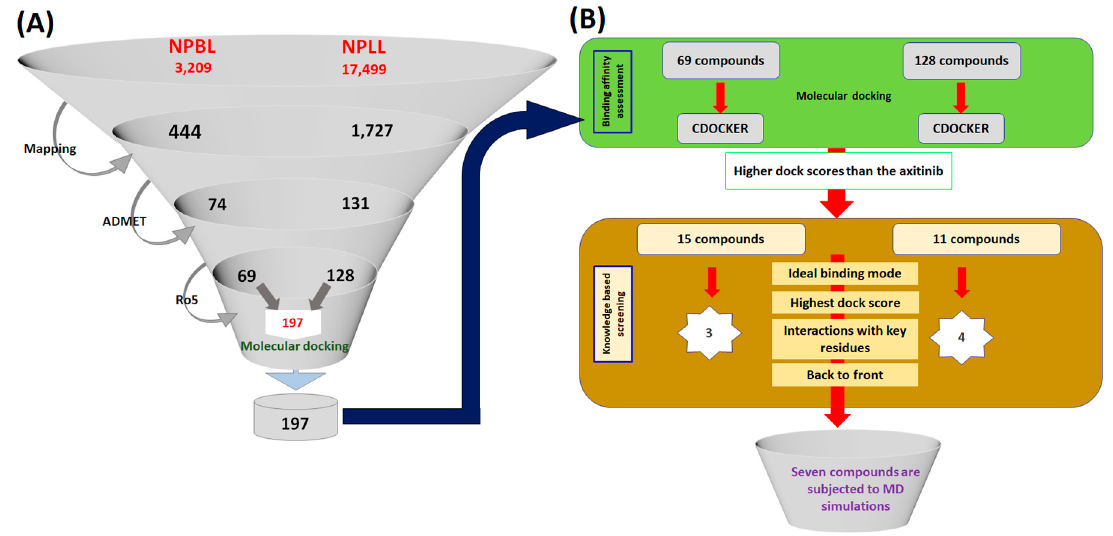
Figure 3. Pictorial depiction of the steps involved in the identification of the potential compounds. ( A ) Illustration of virtual screening and drug-like assessment process. ( B ) Molecular docking guided retrieval of the prospective compounds.